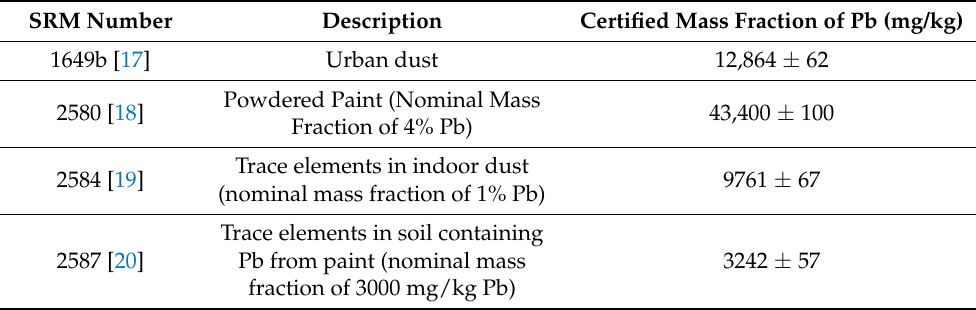
Table 2. Details of NIST standard reference materials with certified Pb mass fractions (with citations for most recently issued certificates of analysis).